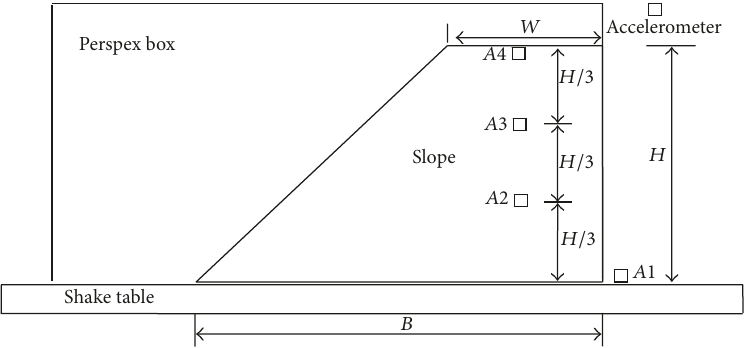
Figure 5: Schematic diagram of typical slope with instrumentation.